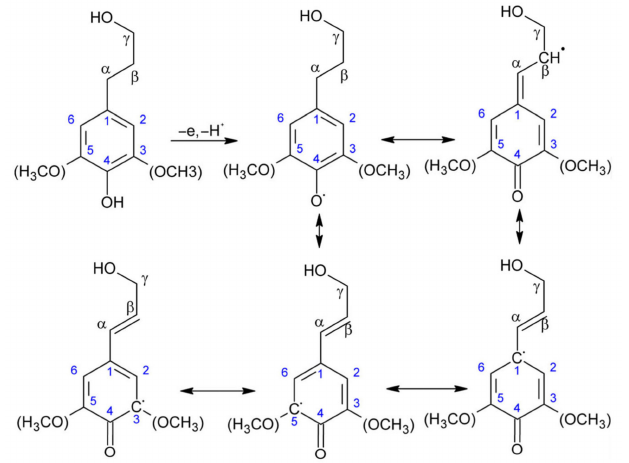
Figure 2. Resonance units of the radical intermediates of the diverse monolignol units during lignin